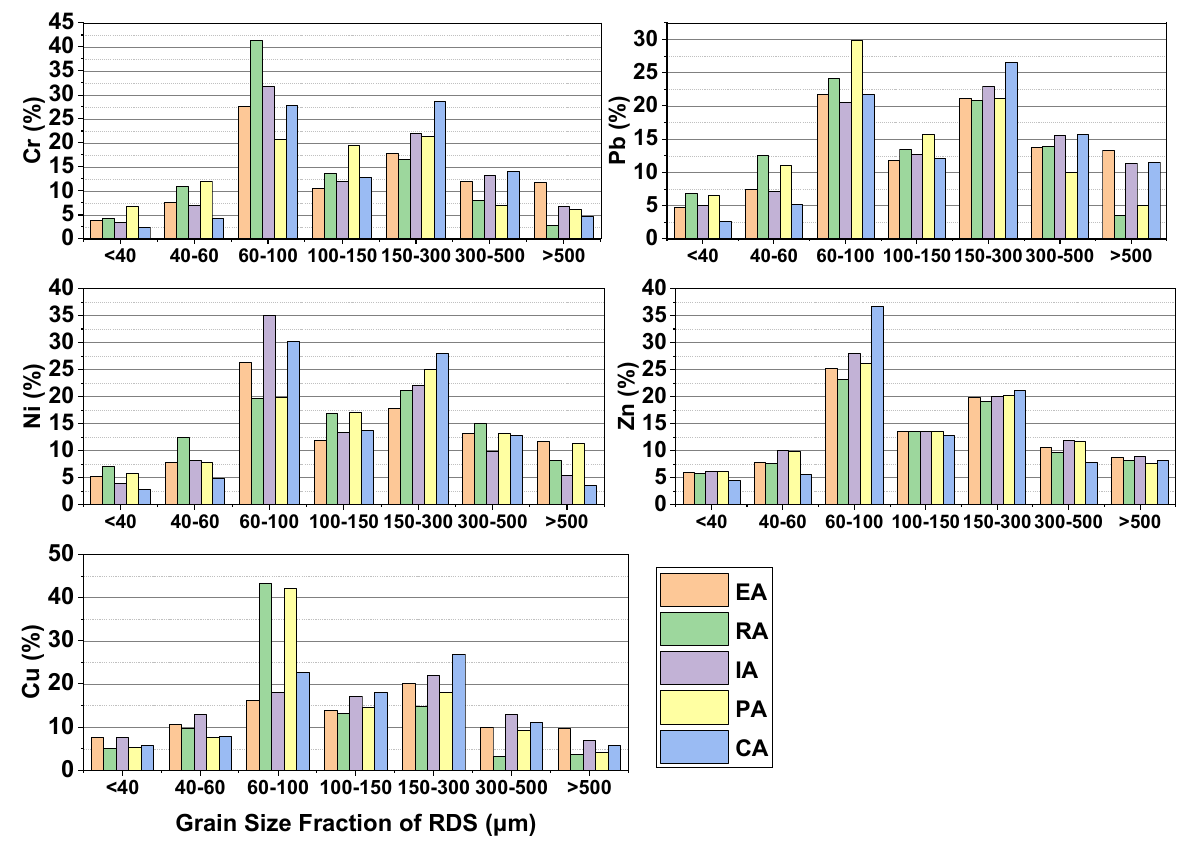
Figure 3. GSF Load (%) of different grain size fractions ( μ m) for different functional areas.